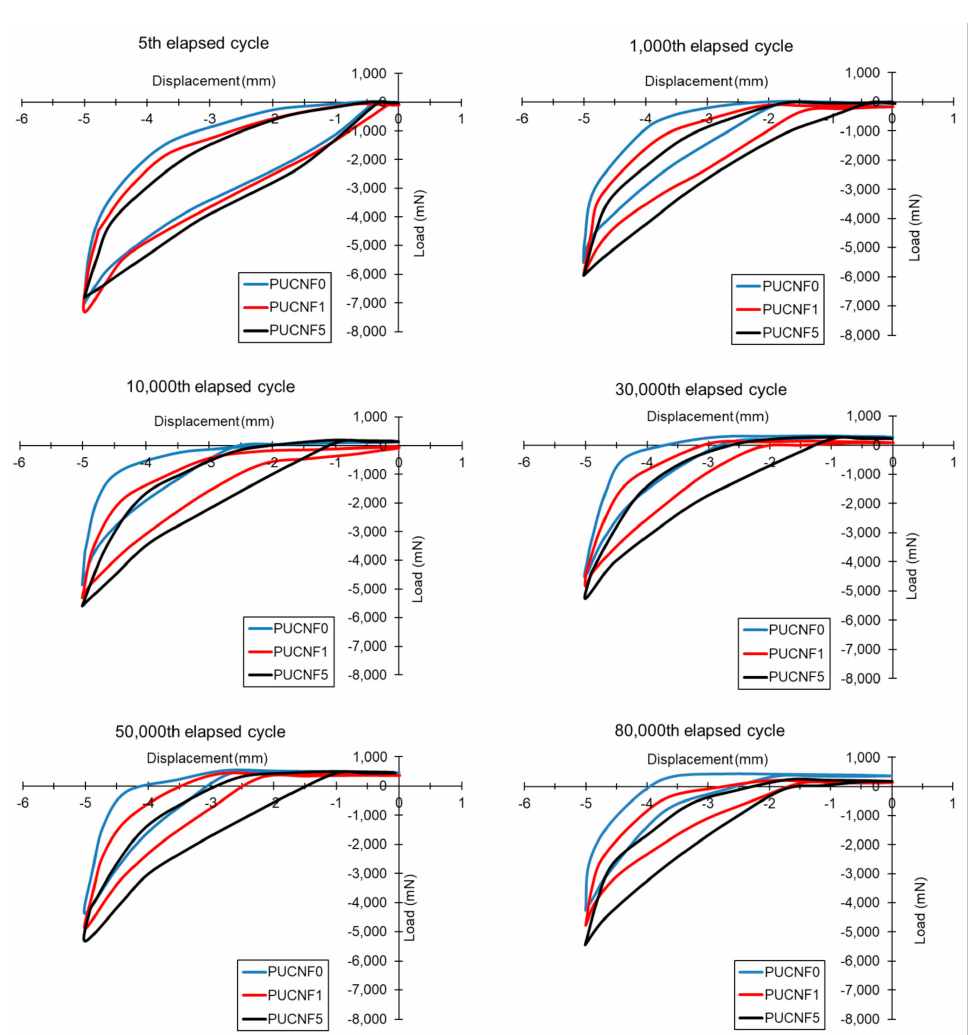
Figure 7. Comparison of the hysteresis behavior of PCUNF0, PCUNF1, and PCUNF5. At the first elapsed cycles, the three samples display a similar trend, however, after only 1000 cycles some differences can be identified. At 10,000 cycles, the hysteresis curve tends to shift towards lower compression loads and maintains a larger area as the amount of CNF present in the sponge increases. This attitude is best appreciated for many cycles and is maximized at 80,000